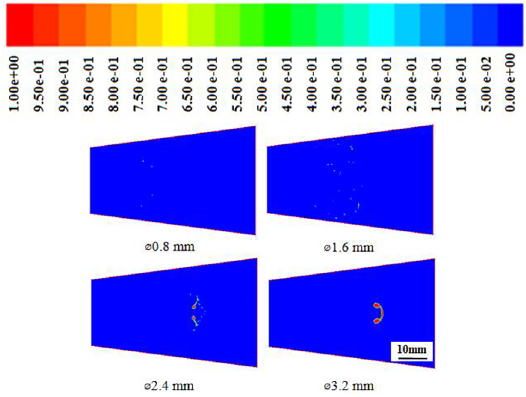
Figure 5. Diameters dependence of TWAS atomized droplet breakup for 0.5 MPa at 30